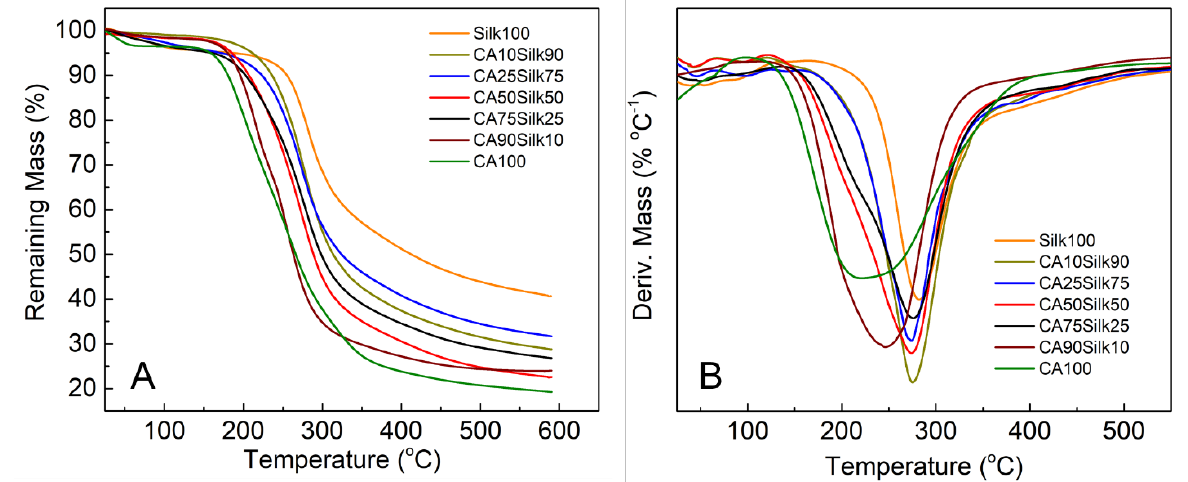
Figure 5. Thermogravimetric analysis of silk-cellulose acetate films: ( A ) remaining mass percent of samples with the